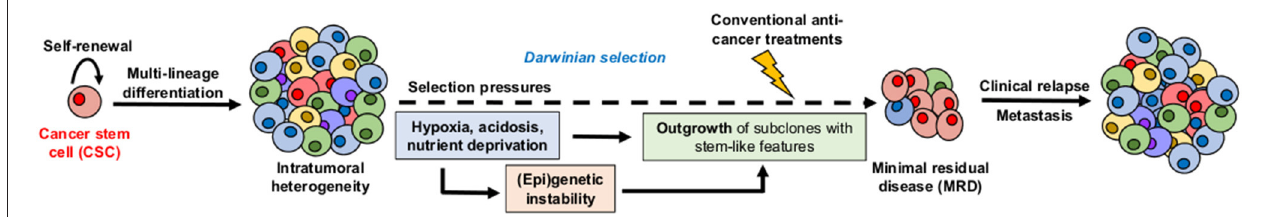
FIGURE 1 | Hypothetical model for the role of cancer stem cells (CSC) and microenvironmental selection pressure in clinical relapse. CSC display both self-renewal capacity and multi-lineage differentiation potential, leading to intratumoral heterogeneity. Local TME peculiarities such as hypoxia, acidosis, and nutrient deprivation act as high selection pressures for adaptive stem-like phenotypes that participate to therapy resistance, minimal residual disease, and long-term clinical relapse.